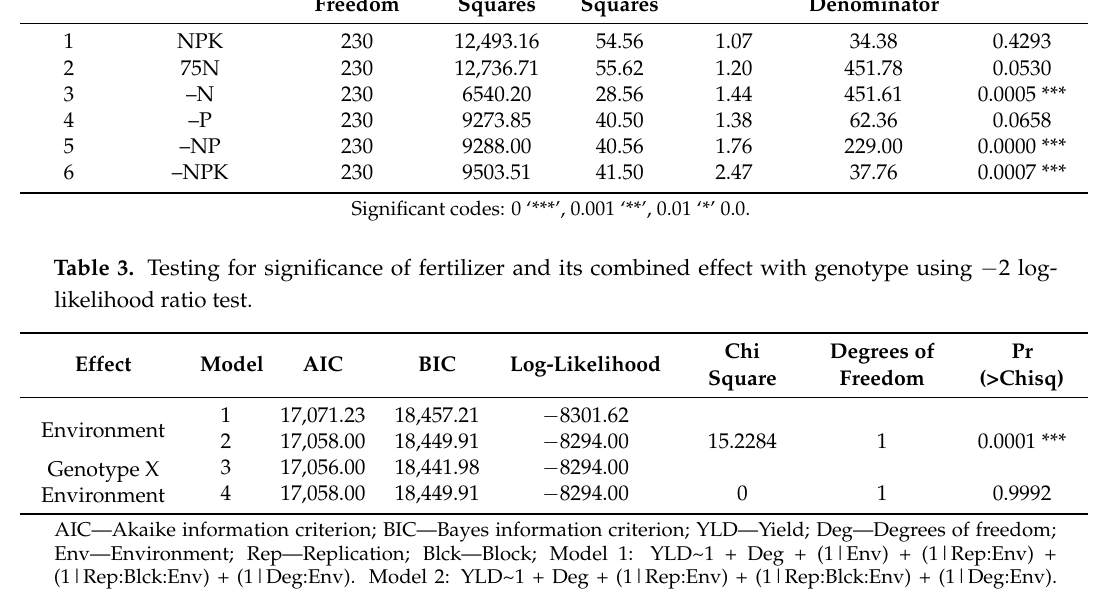
Table 2. ANOVA for the testing of significance of genotype effect per fertilizer condition. S. No.